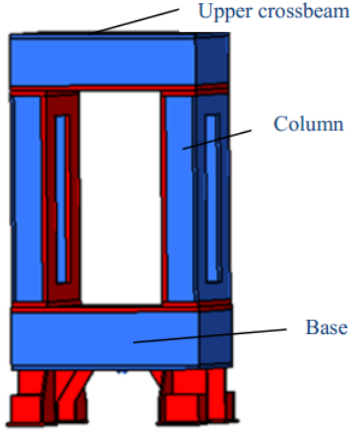
Figure 10. Topology optimization